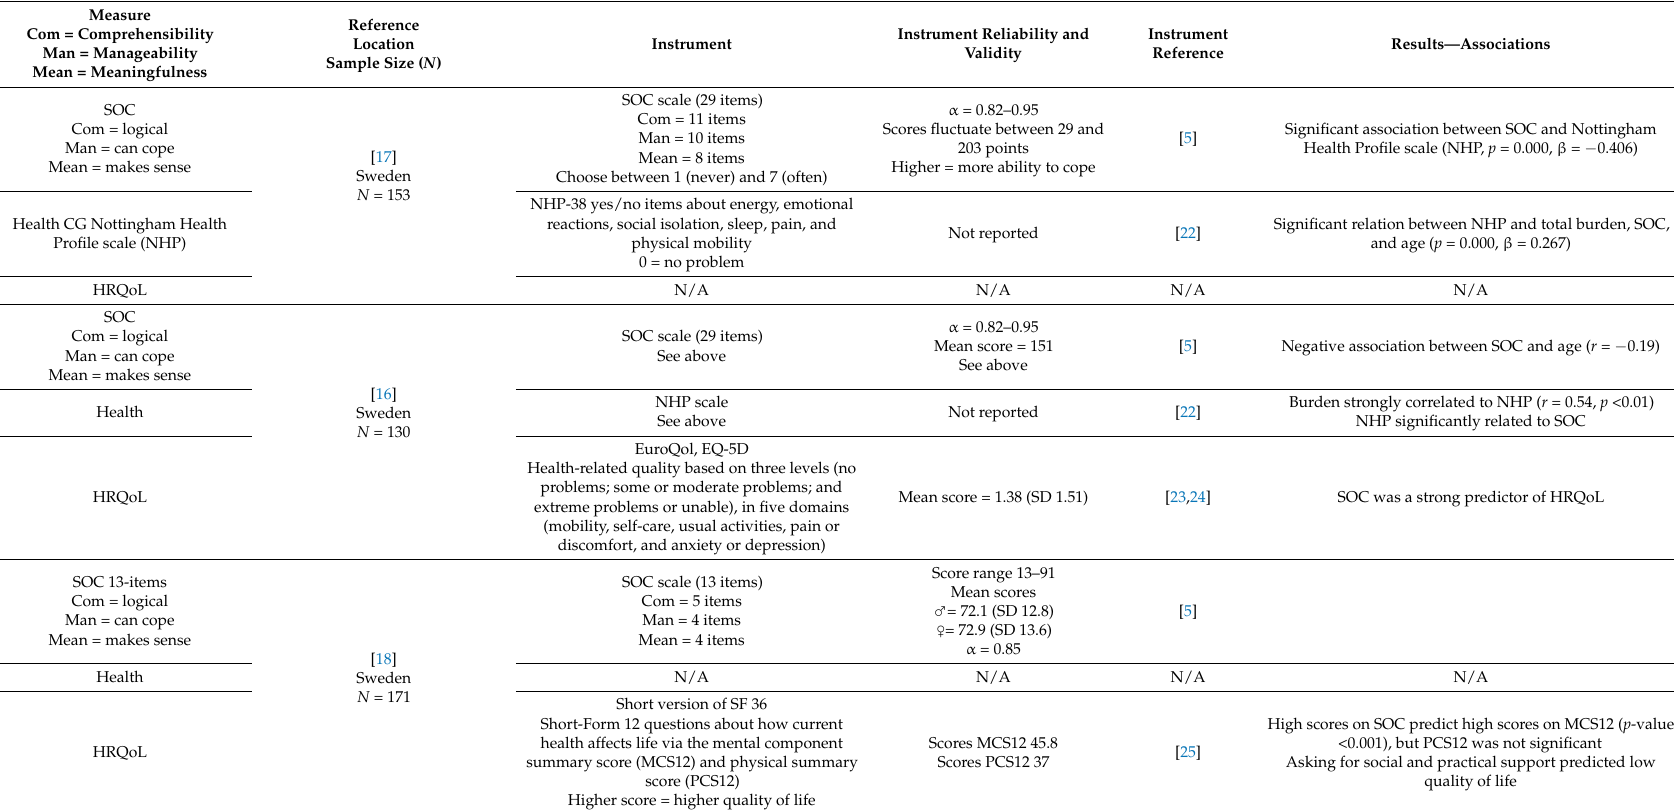
Table 1. Sense of coherence (SOC), health, and health-related quality of life (HRQoL).CG: caregiver; PWD: Persons with Dementia; N/A: not applicable; EuroQoL EQ-5D: European Quality of Life